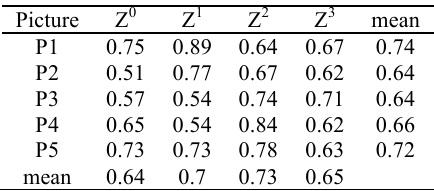
Table 1. Classification accuracies for SVM-MLP method, 10- best features selected using t-statistic.